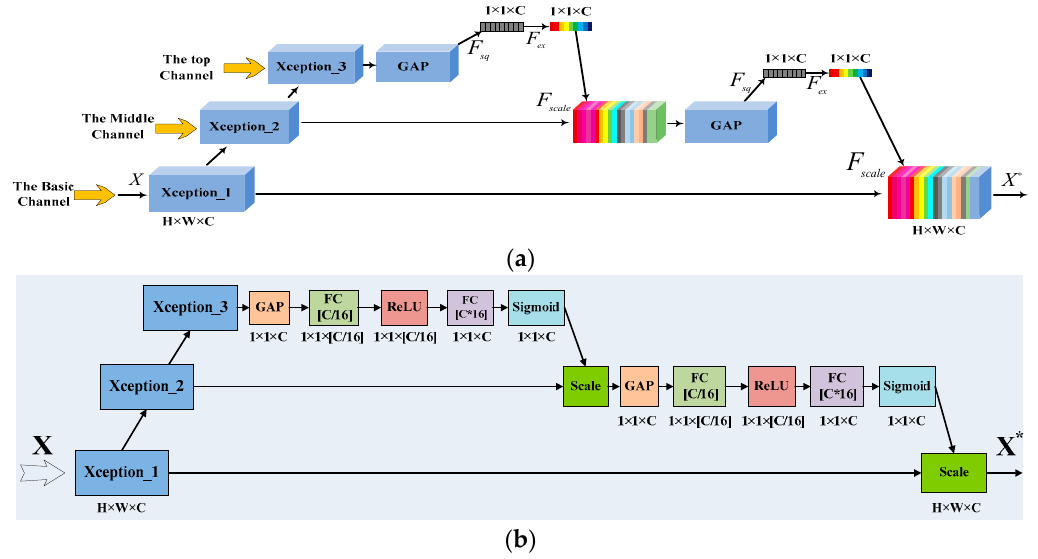
Figure 3. The structure of the New Squeeze-and-Excitation (NSE) Block. ( a ) the workflow of the NSE block, ( b ) the specific layer setting for the workflow of the NSE block.